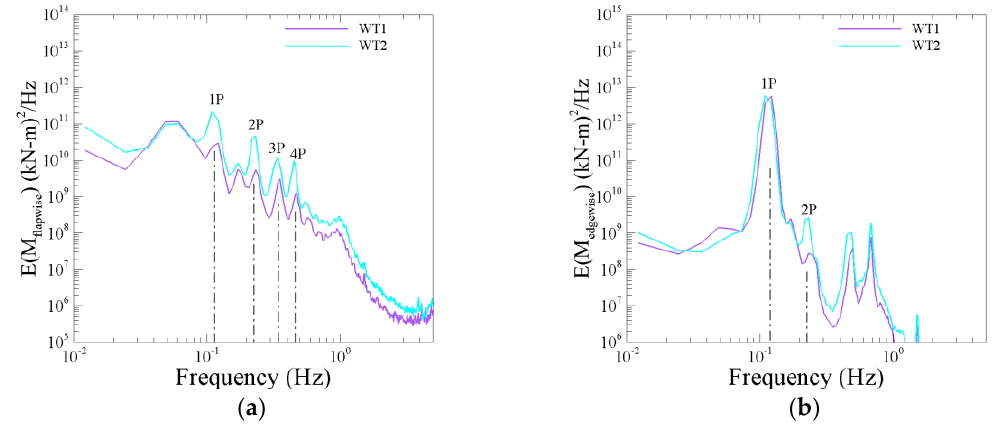
Figure 13. Damage equivalent loads for ( a ) edgewise and ( b ) flapwise blade root moments.